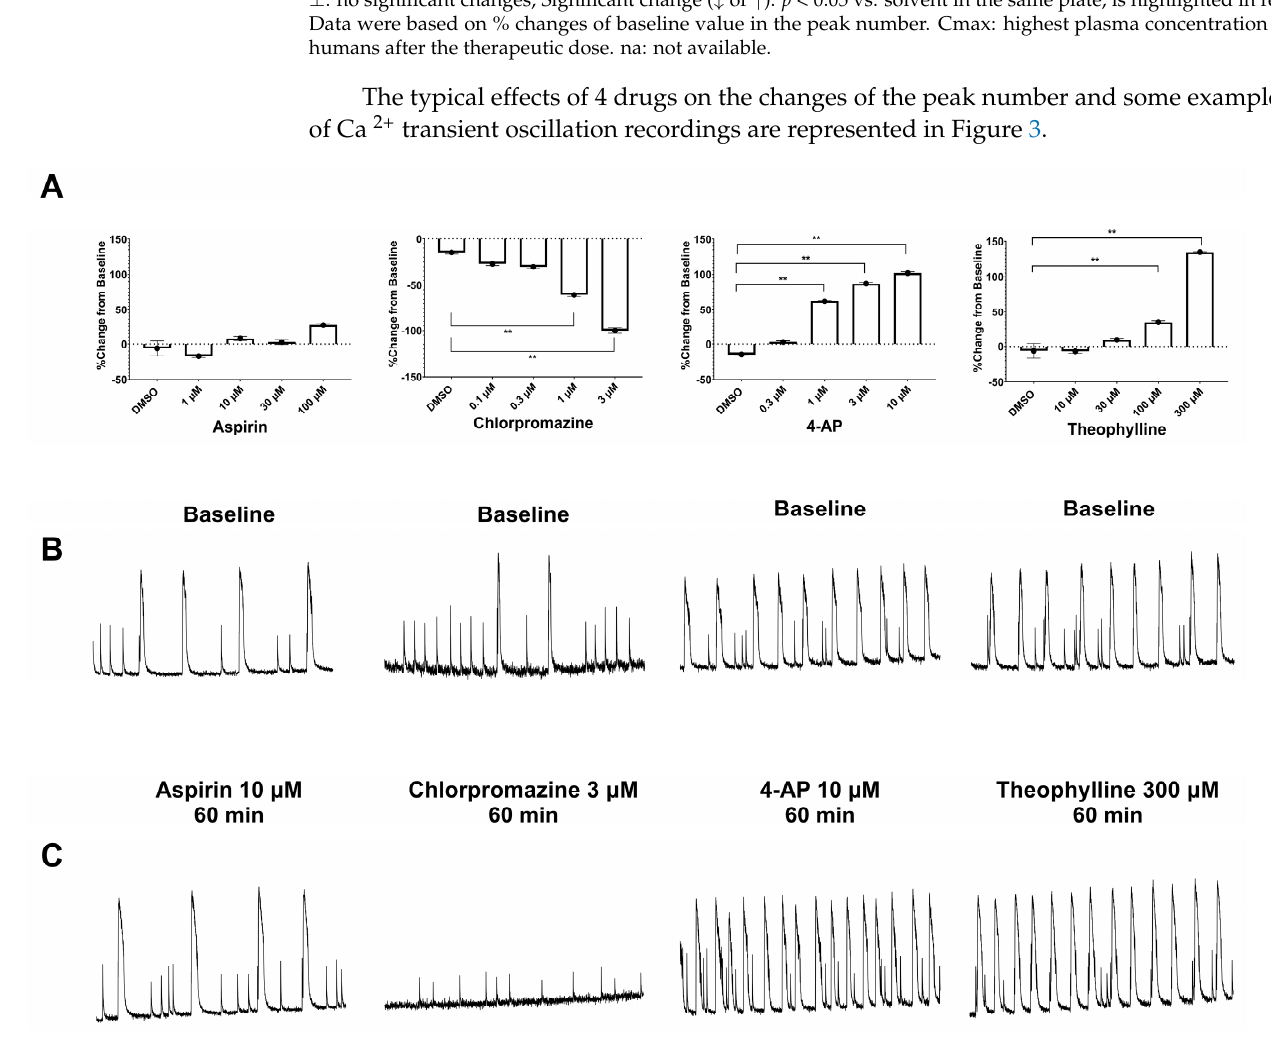
Figure 3. ( A ) Examples of concentration-dependent effects of chlorpromazine, 4-AP, and theophylline, compared to the negative control (aspirin), on the peak number of Ca 2+ neuronal oscillations in hiPSC-derived neurons co-cultured with human primary astrocytes (2D format). **: p < 0.01 vs. 0.1% DMSO. ( B , C ) Examples of Ca 2+ oscillations recorded at baseline ( B ) and 60 min after treatment ( C ) with aspirin, chlorpromazine, 4-AP, or theophylline in hiPSC-derived neurons co-cultured with human primary astrocytes (2D format).